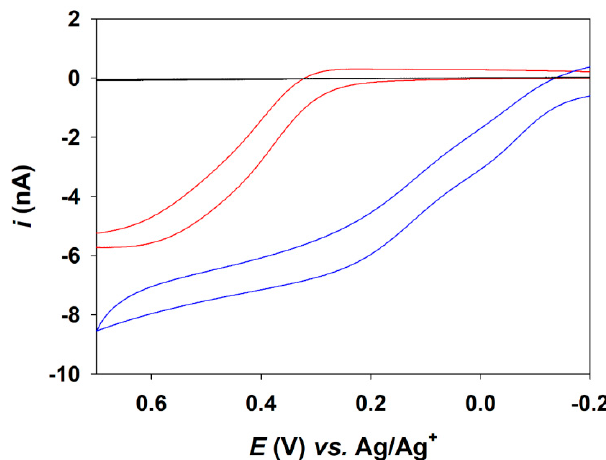
Figure 1. Cyclic voltammetry of 1 mM AP in DCE (black), 1 mM AP in DCE containing 100 mM TBAPF 6 (red), and 1 mM AP in an aqueous solution containing 100 mM MgSO 4 (blue). A 25 um Pt-UME was used, and the scan rate was 100 mV/s.